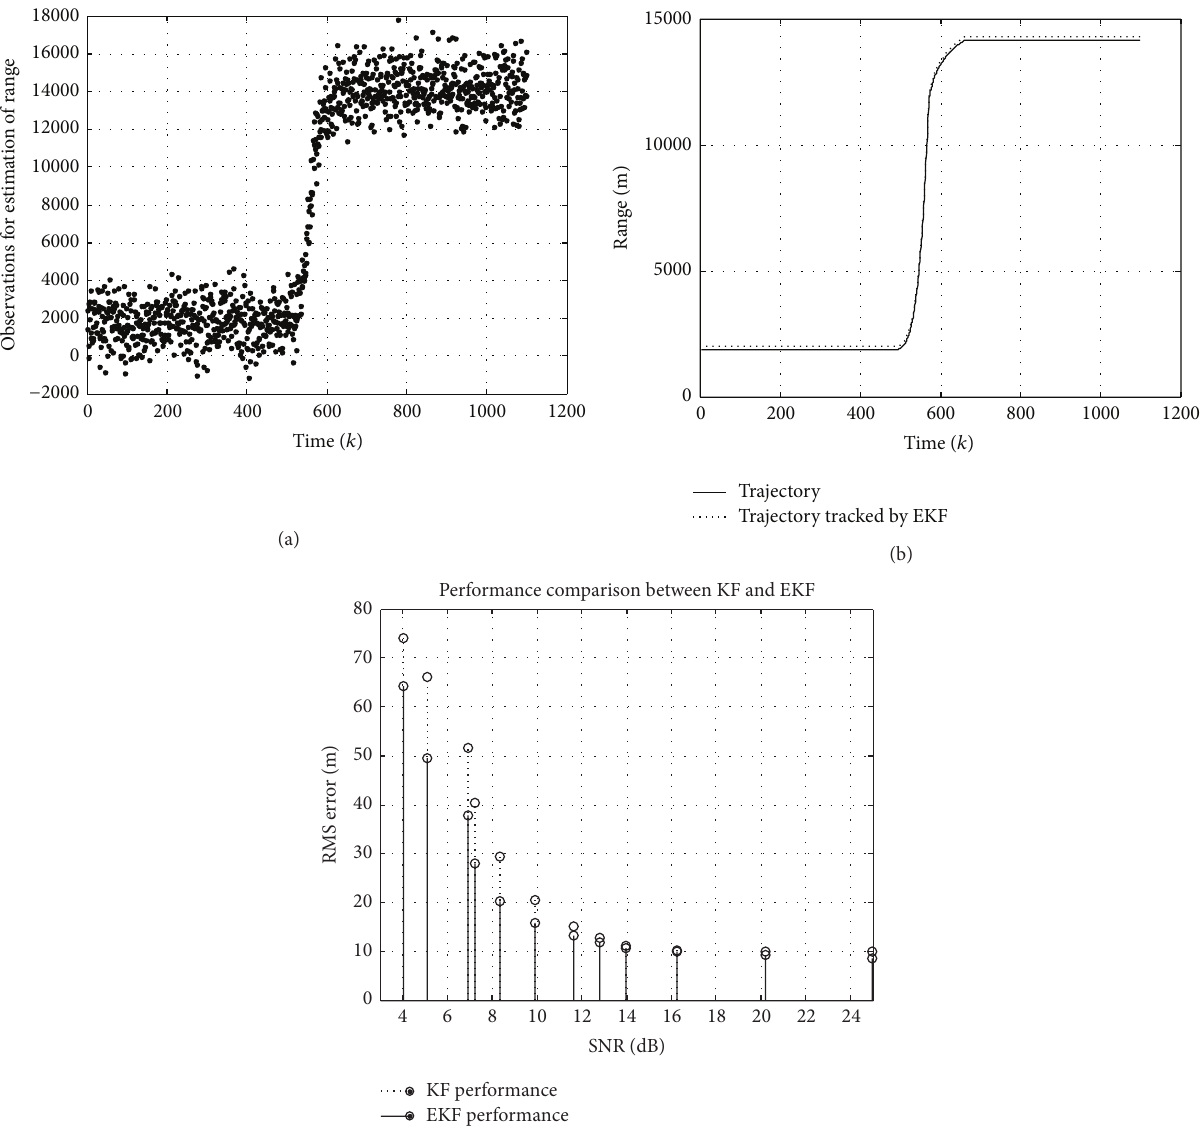
Figure 6: (a) Observations; (b) the target range estimation using EKF; (c) SNR versus RMS